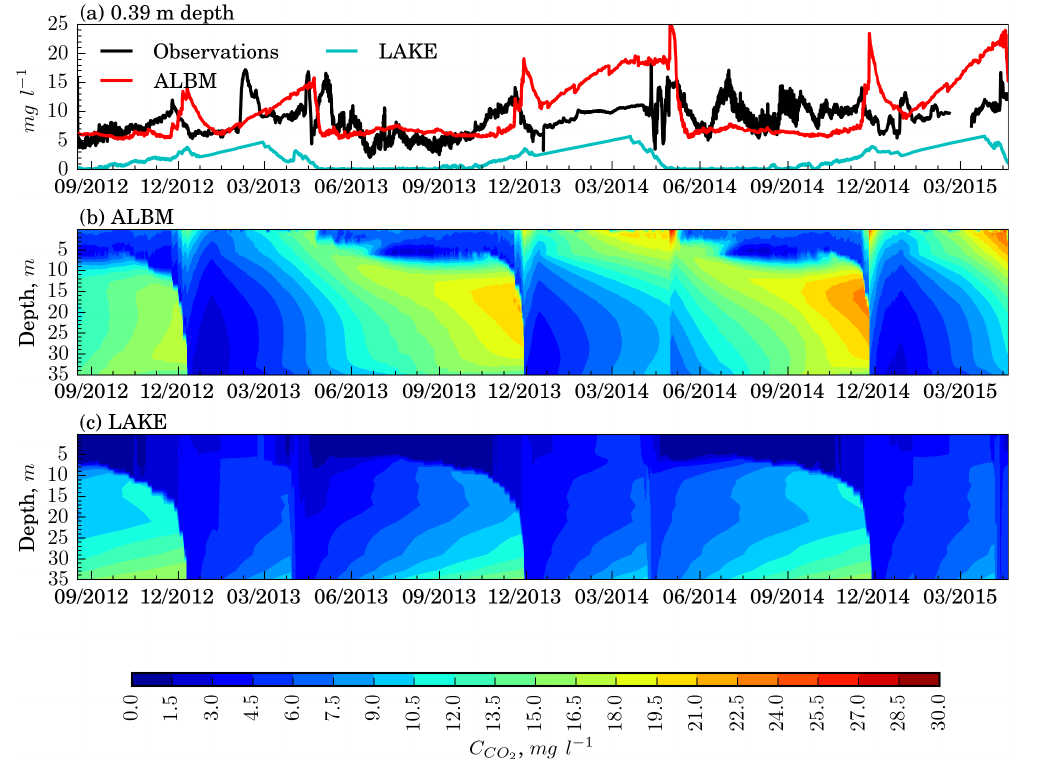
Figure 9. Time–depth profiles of CO 2 concentration in Harp Lake (17 August 2012–20 April 2015), experiment including modules of sediments and morphometry